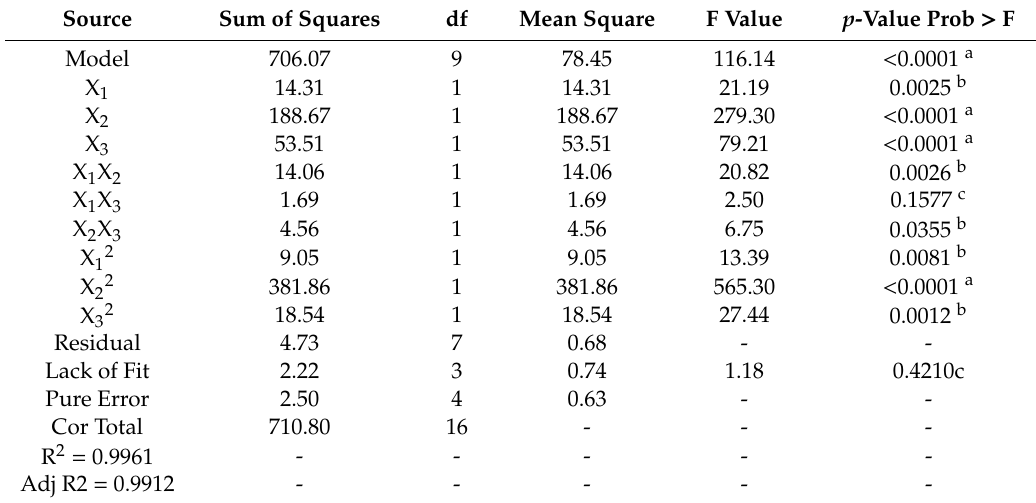
Table 1. Analysis of Variance (ANOVA) for the response surface